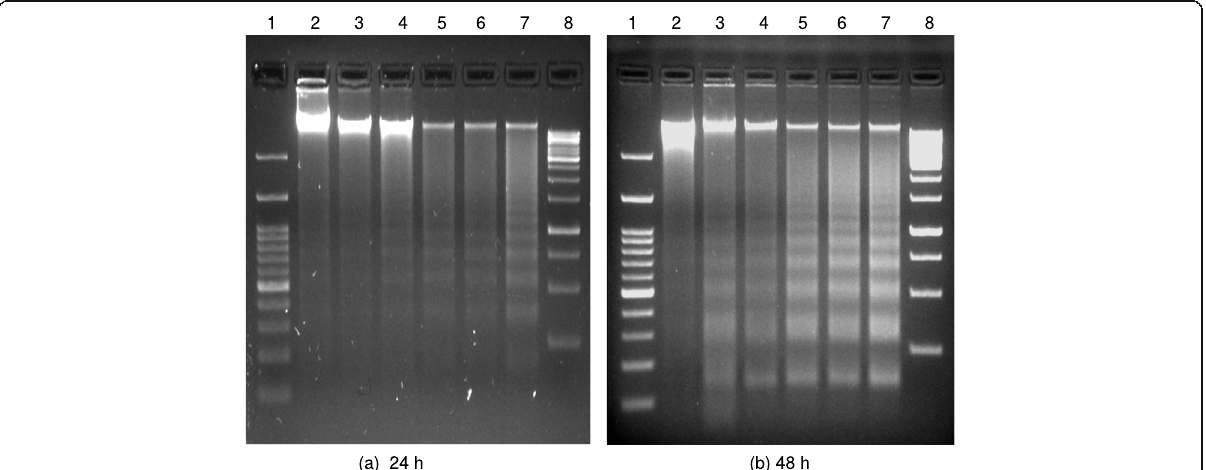
Fig. 5 Representative agarose gel images showing DNA fragmentation pattern of HCT-15 cells exposed to different concentrations of AM-AuNPs after different time periods of exposure a 24 h and b 48 h. In each representative gel, lane 1 is 100 bp ladder; lane 2: DNA of control; followed by lanes 3 – 7: DNA of AM-AuNP-treated HCT-15 cells exposed to 5, 10, 20, 25, and 50 μ g/mL respectively of lane 8 is 1 kb ladder